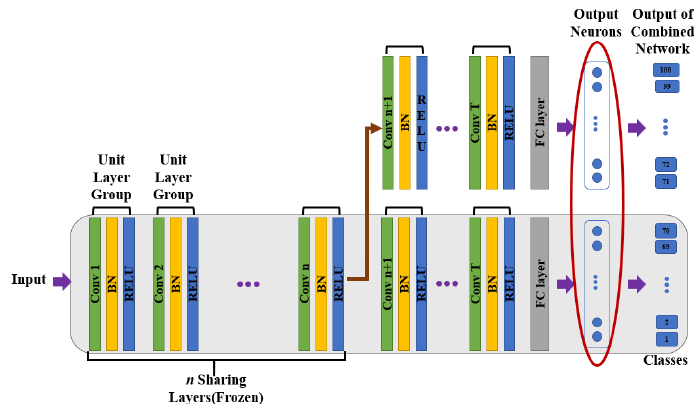
Figure 1. The incremental network structure called ‘clone and branch’. The shaded gray rectangle is the base network. Each time we update the network for the new task, some initial parts of convolutional layers are shared and frozen, so only the branch part of layers is retrained with the new task data, while the last layers of the base network remain